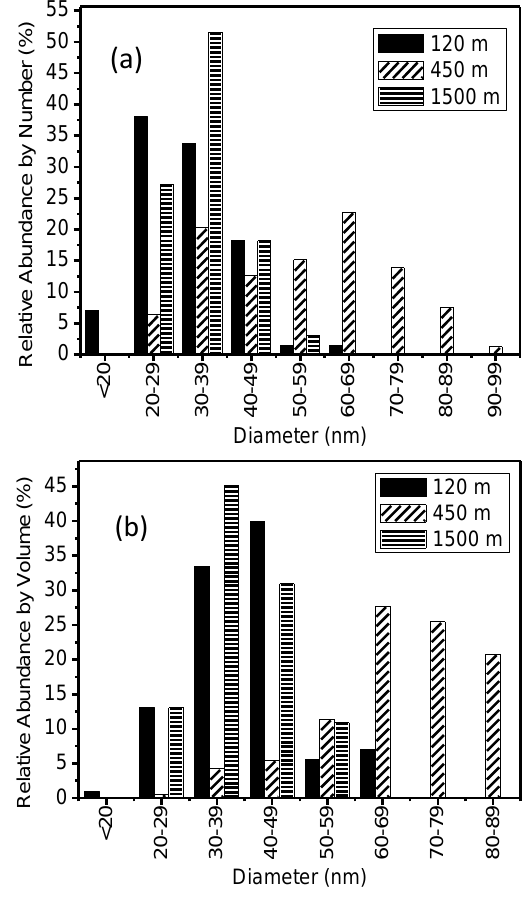
Fig. 5b Fig. 5. Relative abundance by number (a) and volume (b) at differ-